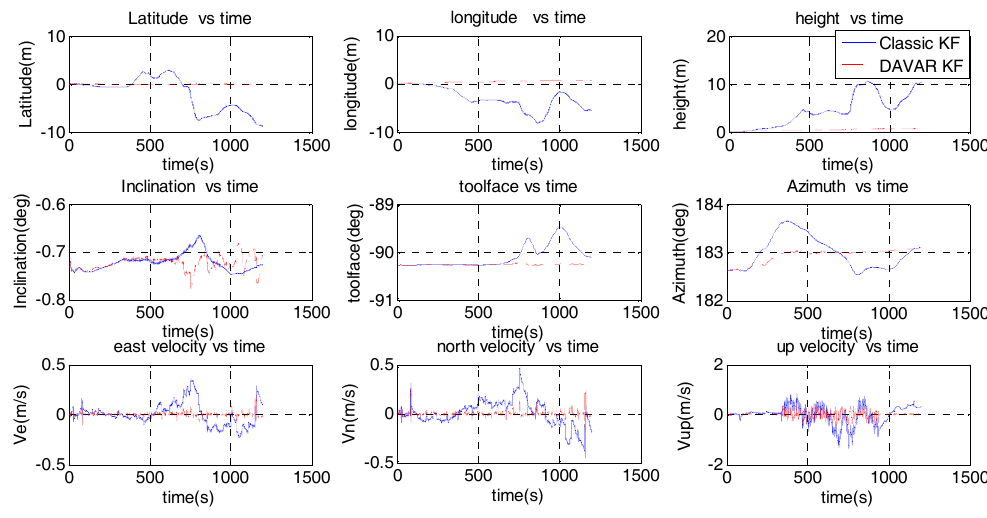
Figure 12. Navigation results of the random vibration.